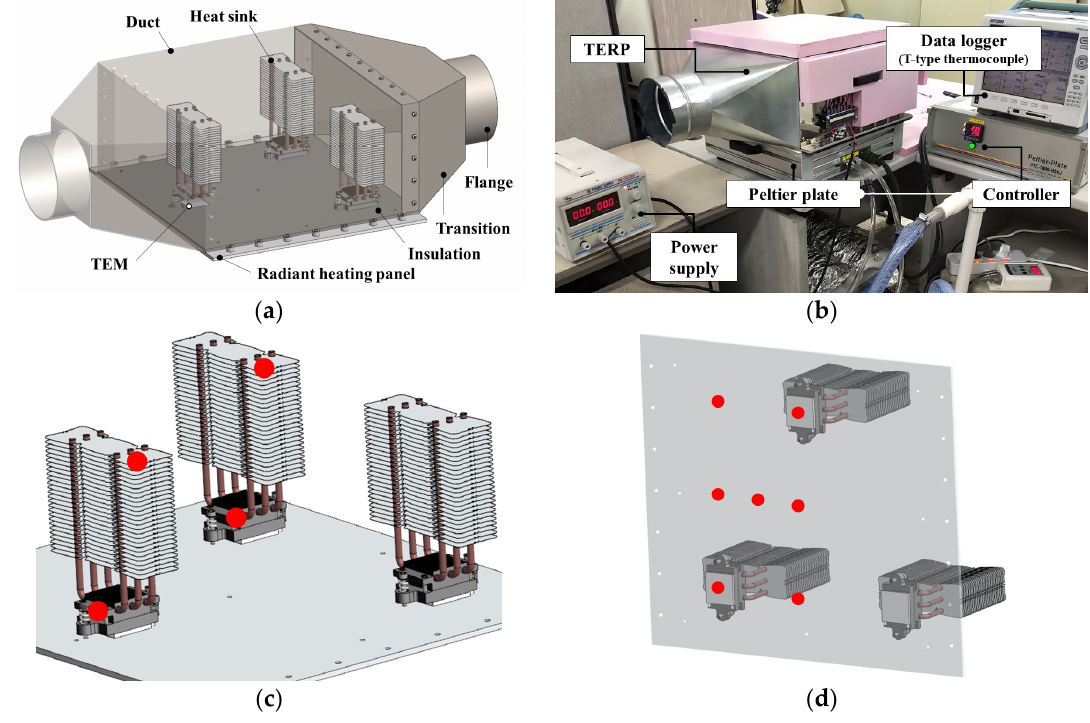
Figure 5. Experimental setup for the TERP: ( a ) three dimensional model of mockup; ( b ) experimental equipment; ( c ) sensors for the heat fin and base plate; and ( d ) sensors for the radiant panel.